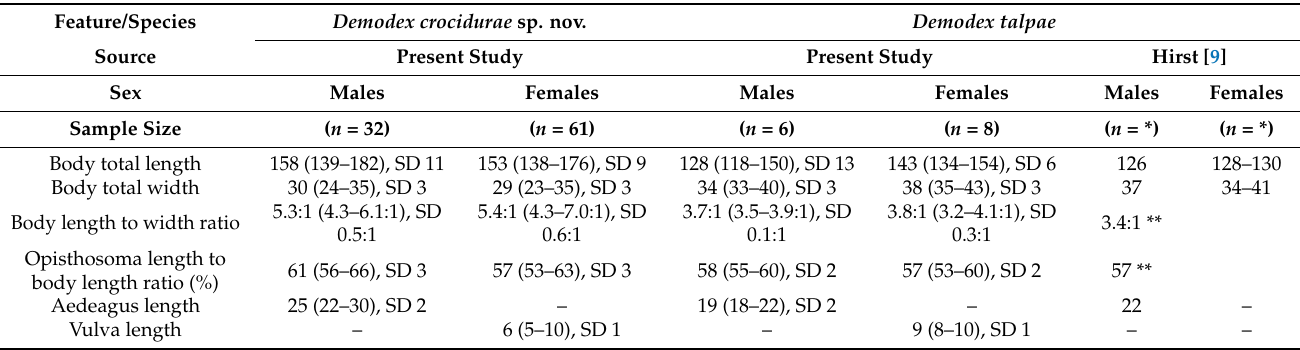
Table 3. Morphometric comparison between Demodex crocidurae sp. nov. and Demodex talpae . Feature/Species Demodex crocidurae sp.